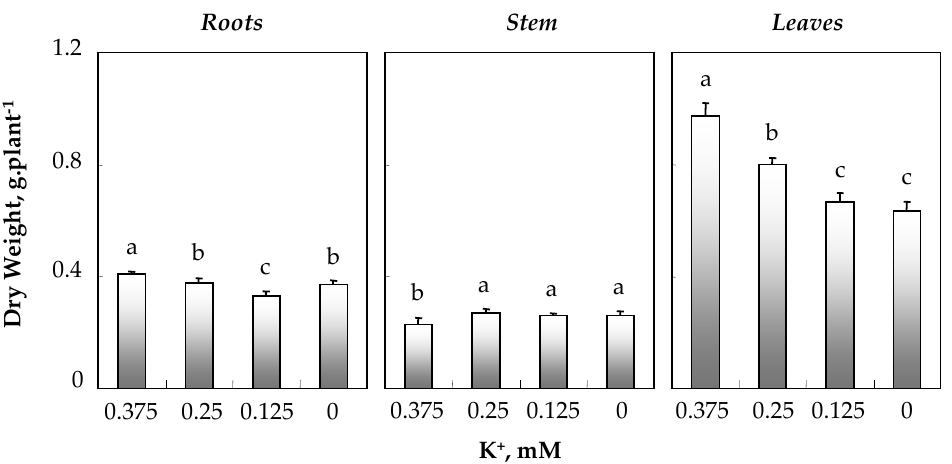
Figure 2. Dry weights of root, stem and all leaves of O. basilicum plants grown for 30 days in the presence of varying K + concentrations (0.375; 0.25; 0.125 and 0 mM). Means of eight replicates and confidence intervals at the 5% level are presented. Bars with the same letters as indicated in the Figure are not significantly different according to Duncan’s test at p < 0.05.